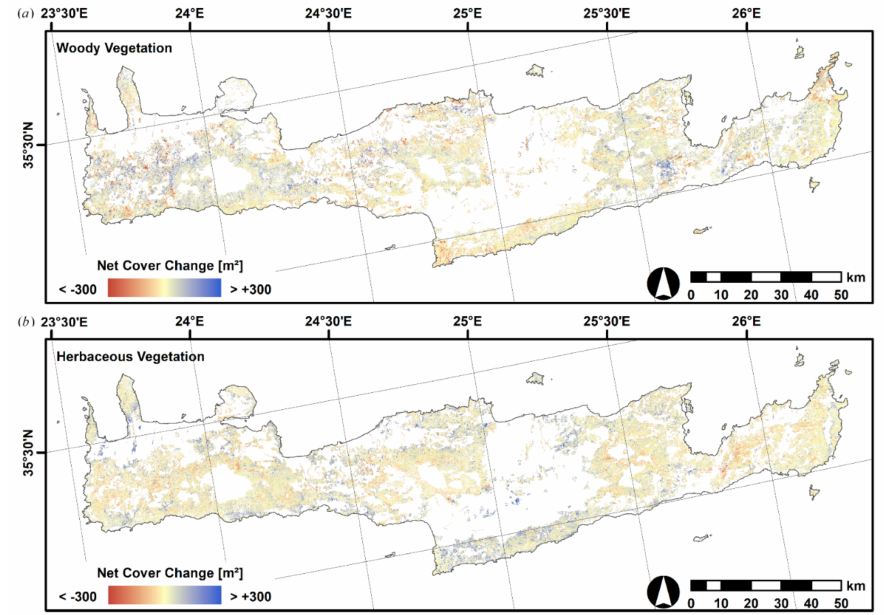
Figure 10. Net cover change for the woody ( a ) and herbaceous vegetation ( b ) over the study period 1984–2006. Net cover change is in m 2 . The complete removal of a completely vegetated pixel (e.g., a dense forest) would result in a loss of − 900 m 2 . White areas are non-natural areas or above 1500 m a.s.l., which were out of scope of this